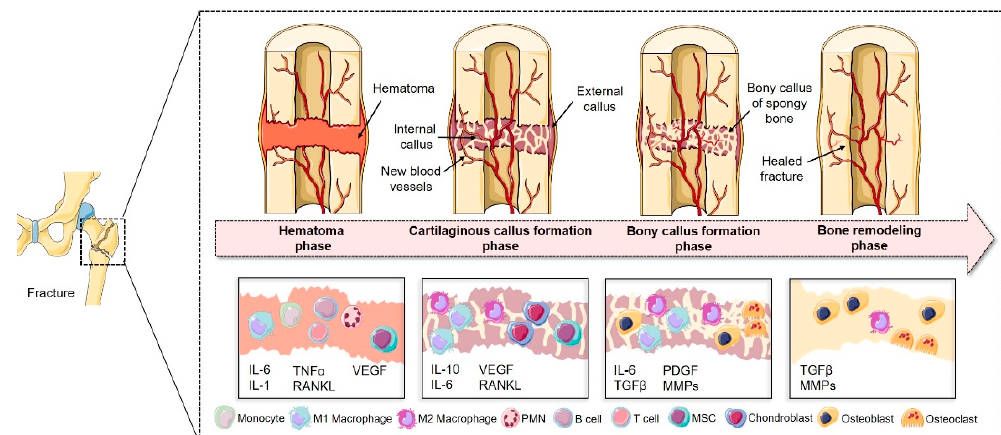
Figure 1. Schematic description of the four phases of fracture healing: The first phase is characterized by the formation of the fracture hematoma and a local inflammation. Immune cells, such as peripheral multinucleated cells (PMN), T- and B-cells, monocytes and MSCs, are activated and recruited towards the fracture gap via autocrine and paracrine pathways (e.g., by the release of cytokines such as interleukin (IL-1), IL-6 or tumor necrosis factor (TNF α )). Activation of, for instance, vascular endothelial growth factor (VEGF) also paves the way for revascularization in this early phase. In the following phase, chondroprogenitor cells differentiate into chondroblasts and start to build an early fibrocartilaginous bridging area, while angiogenic processes are also upheld. The third phase is characterized by endochondral ossification, thereby substituting cartilage with primitive bone tissue. In the last phase bone structure and function is completely restored by the constrict interplay of bone-forming and bone-resorbing cells. Figure was modified from Servier Medical Art, licensed under a Creative Common Attribution 3.0 Generic License.